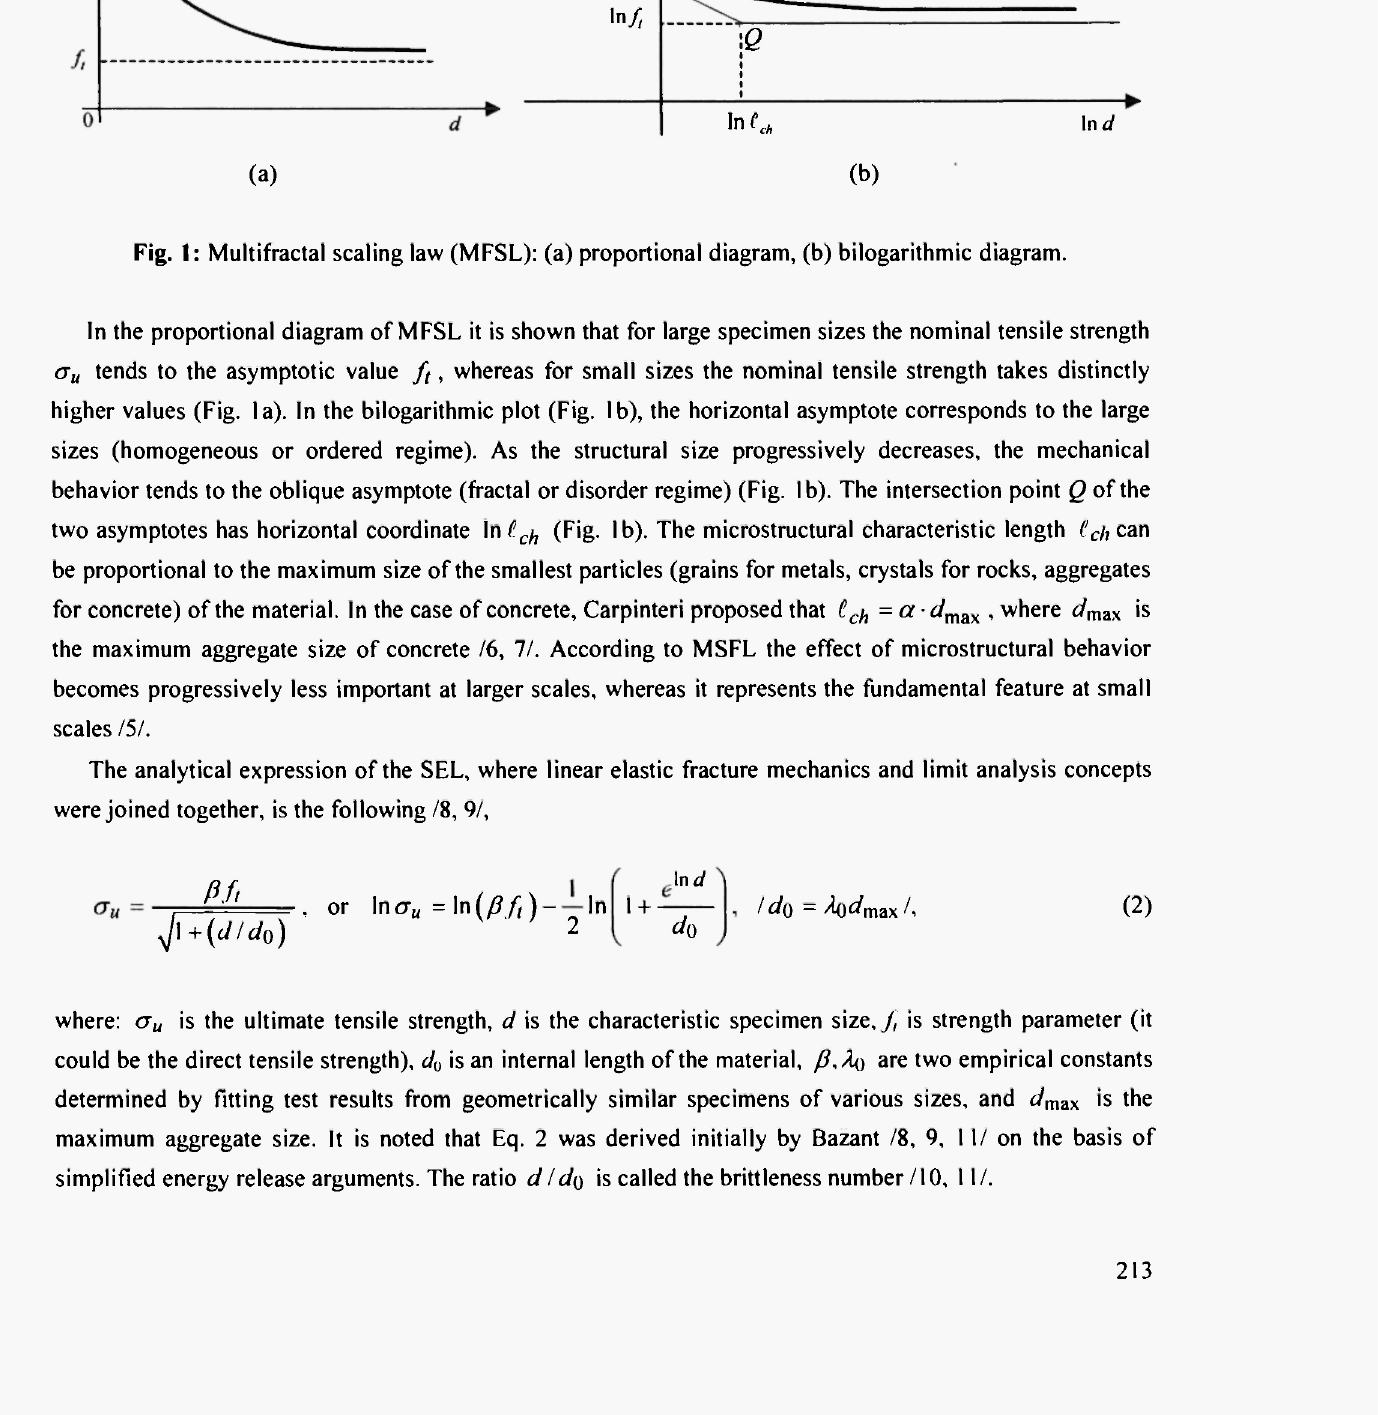
Fig. ί : Multifractal scaling law (MFSL): (a) proportional diagram, (b) bilogarithmic diagram.